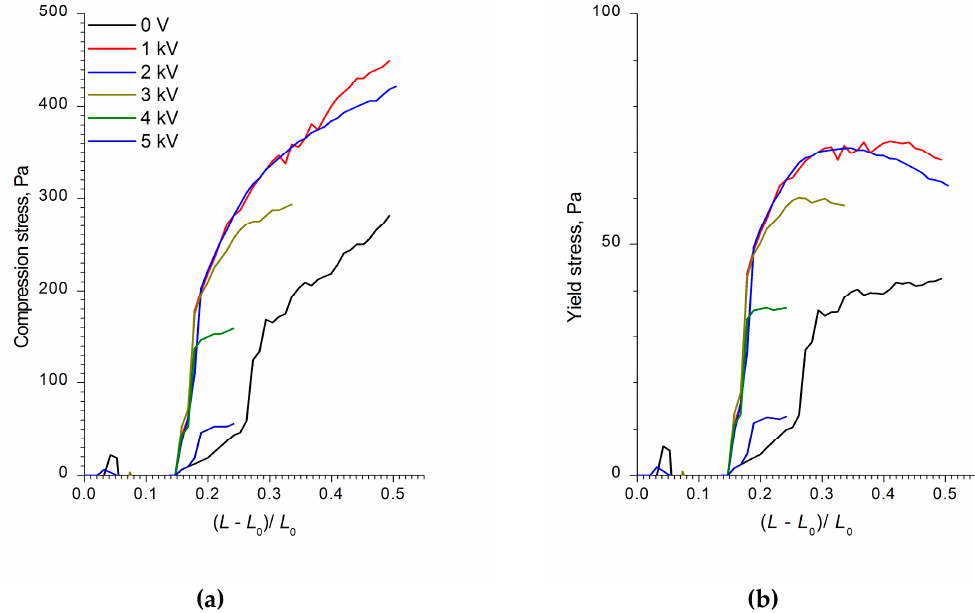
Figure 4. The dependences of ( a ) the compression stress and ( b ) the yield stress of ER fluid with 60 wt% WO 3 /DDA on the deformation degree at various values of voltage applied. The initial gap L 0 between the electrodes was 2 mm.